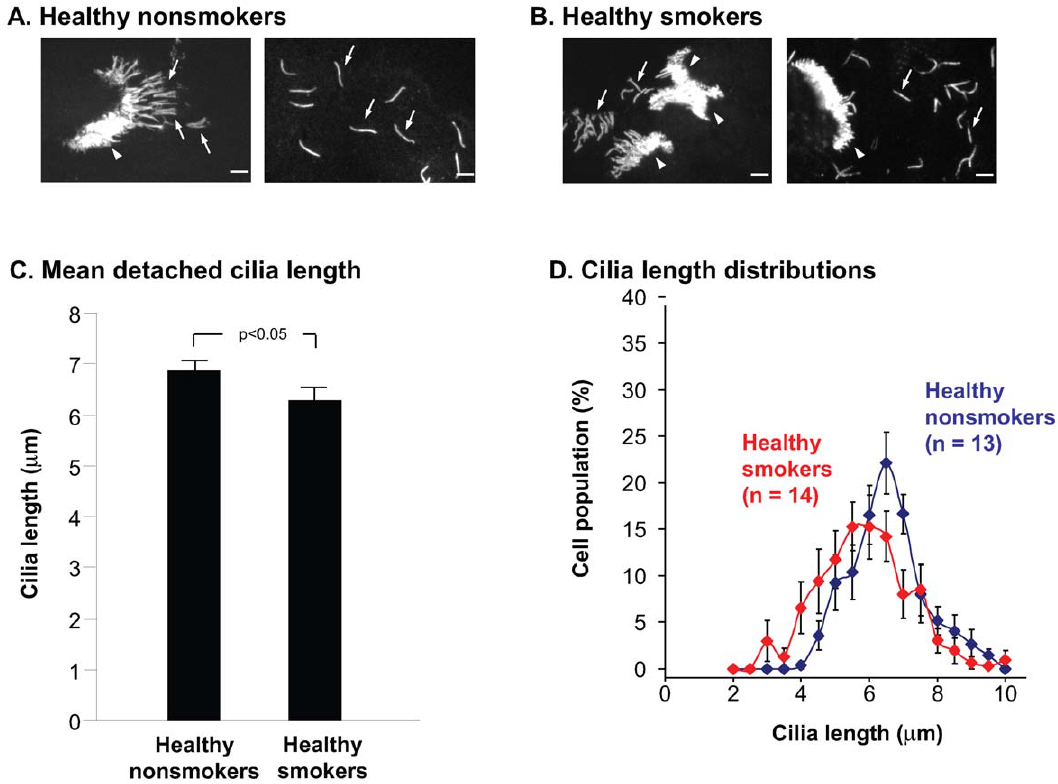
Figure 3. Cilia length in detached cilia from airway epithelial cells of normal smokers and nonsmokers. Suspensions of airway epithelial cells were applied to glass slides using a cytocentrifuge, air-dried, fixed in 4% paraformaldehyde, and stained with an antibody against ’ 4-tubulin. Fields include cilia that were detached from cells (arrows) as well as cilia that remain attached to the apical surface of cells (arrowheads). Only detached cilia that were visible from end-to-end were included in the analysis. (A) Detached cilia in airway epithelial cells from normal nonsmokers. Bar =5 m. (B) Detached cilia in airway epithelial cells from normal smokers. Bar =5 m. (C) Quantitative assessment of cilia length in detached cilia from normal nonsmokers and normal smokers. Shown are the mean standard error of cilia lengths for nonsmokers (n=13) and smokers (n=14). Between 5 and 103 individual measurements were made per study individual (median =54). (D) Distribution of cilia lengths in airway epithelial cells from normal nonsmokers and normal smokers. Distributions were constructed by creating histograms from 0.5 micron bins and then equally weighting each study